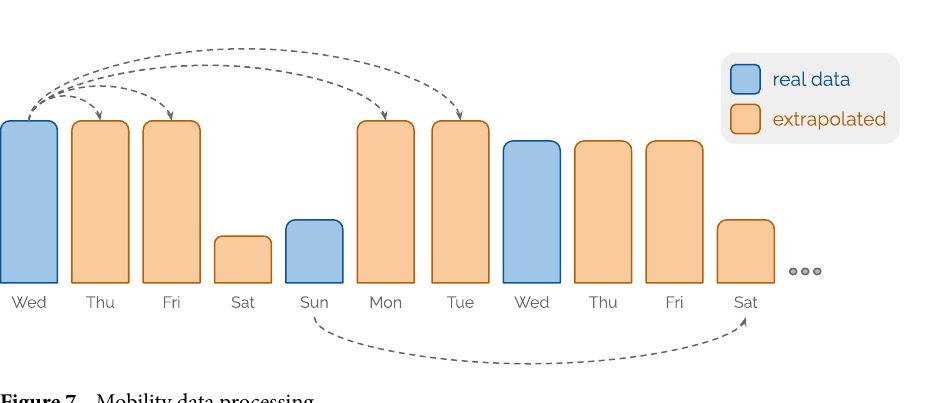
Figure 7. Mobility data